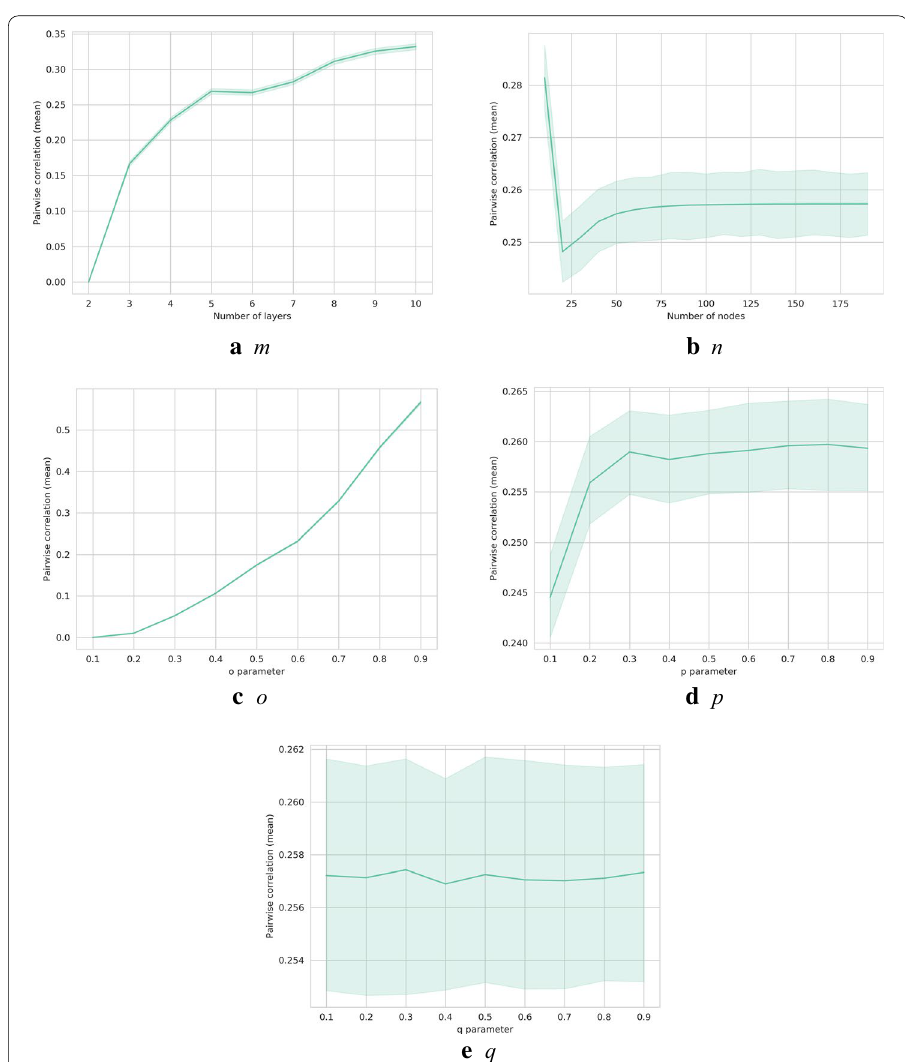
Fig. 29 Comparison of the distribution of (averaged, with min/max) correlations as a function of: a number of layer m , b number of nodes n , c layer assignment probability o , d inner-layer edge probability p , and e transition coupling edge probability